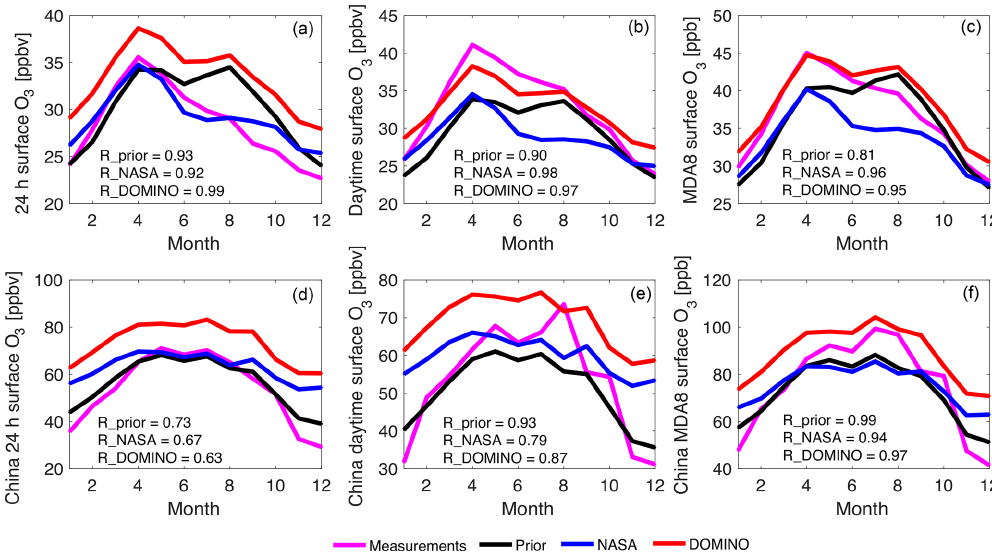
Figure 5. Seasonality of surface ozone concentration at 2m in 2010 compared with TOAR (a, b, c) and in 2015 compared with CNEMC (d, e, f) . Surface measurements are shown with magenta lines. Simulations are performed using GCv12 with NO x emissions from CEDS (black line), NASA posterior emissions (blue line), and DOMINO posterior emissions (red